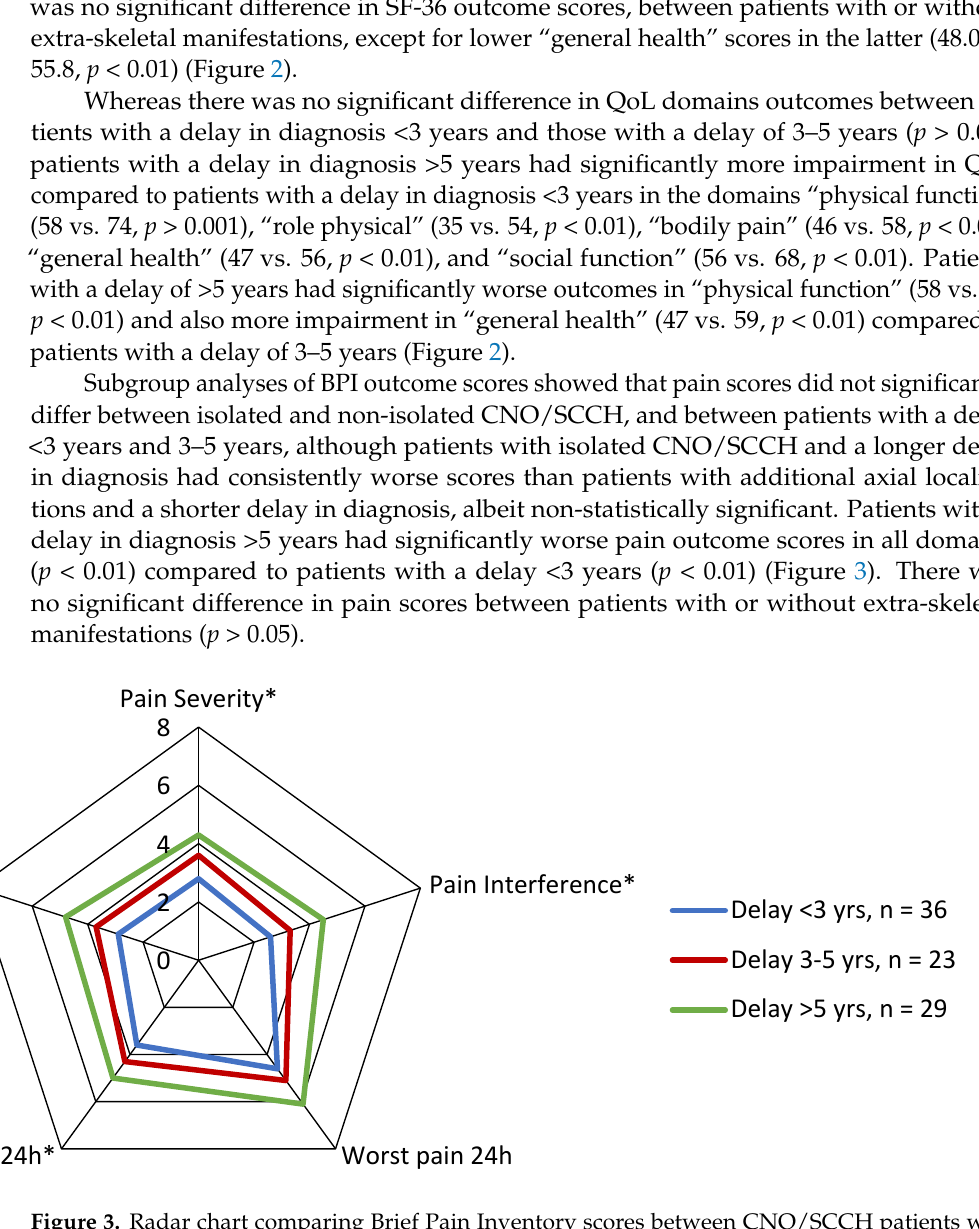
Table 2. Outcome of the Shoulder Rating Questionnaire scores in CNO/SCCH patients.